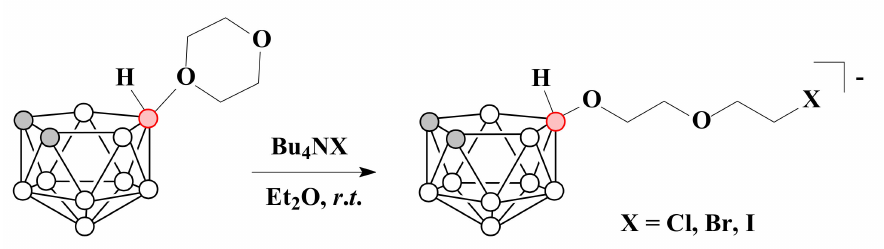
Scheme 18. The reactions of 1,4-dioxane derivative of nido -carborane with halide ions. The ring-opening reaction of 1,4-dioxane derivative of nido -carborane with KOH under mild conditions in biphasic system of diethyl ether and 2,5M aqueous KOH proceeded with the formation of [10-HO-CH 2 CH 2 OCH 2 CH 2 O-7,8-C 2 B 9 H 11 ] − , whereas the heating of 10-O(CH 2 CH 2 ) 2 O-7,8-C 2 B 9 H 11 in 2,5M aqueous KOH through deprotonation of bridge hydrogen led to the substitution of the ether by hydroxyl group [10-HO-7,8-C 2 B 9 H 11 ] − [71] (Scheme